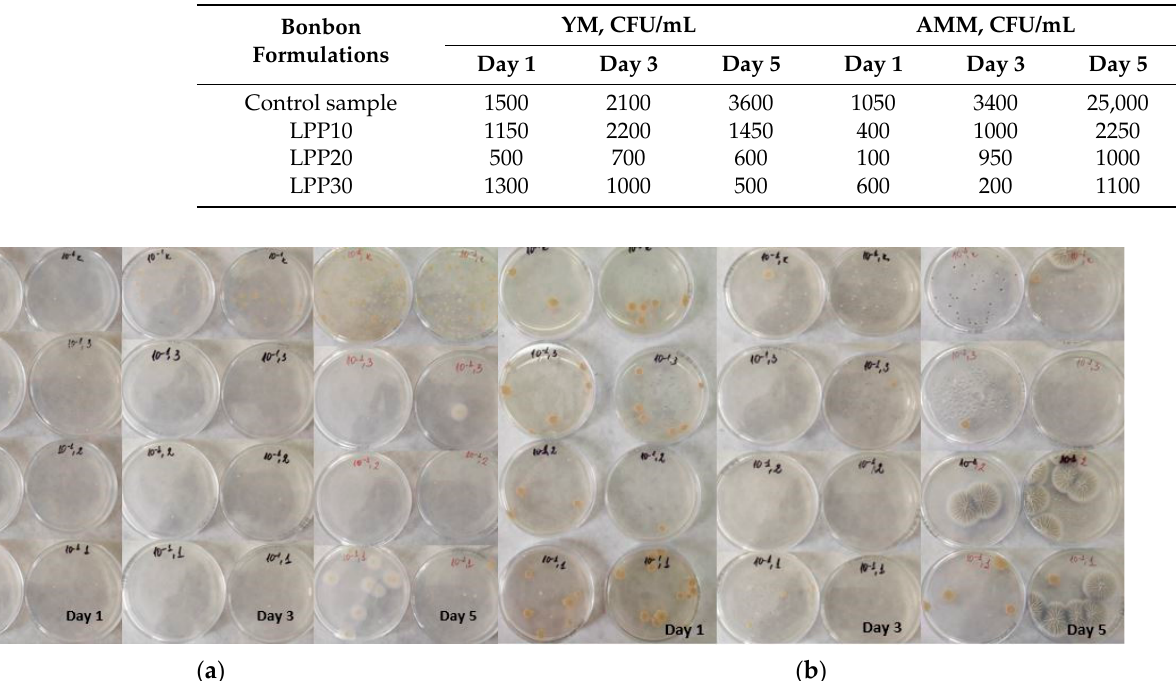
Table 8. Microbial count of bonbon formulations: YM—yeasts and molds; AMM—aerobic meso- philic microorganisms.